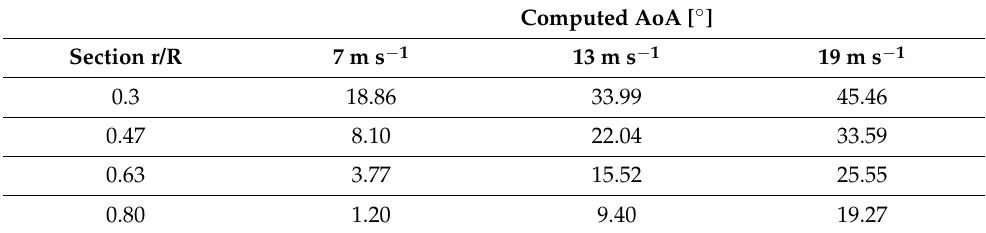
Table 3. The values of the angle of attack at different blade sections.